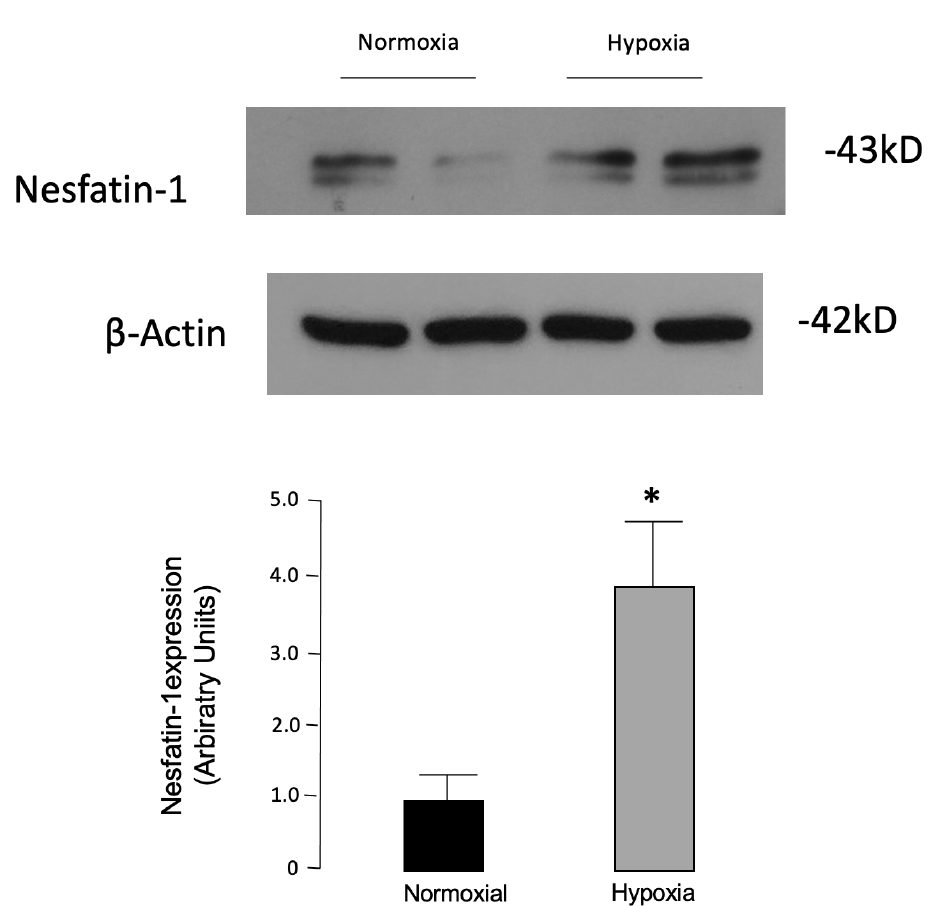
Figure 1. Effects of hypoxia on nesfatin-1 protein expression in murine 3T3-L1 adipocytes. Fully differentiated 3T3-L1 adipocytes were incubated under hypoxic conditions (2% O 2 ) for 24 h maintained in normoxia (21% O 2 ). Western blot analysis was performed with 3L3-L1 protein extracts using an anti-nesfatin antibody. Beta-actin antibody served as the protein loading control. Representative WBs of three separate experiments and mean densitometric analyses of WBs performed in 3T3-L1 cells under different oxygen tension are shown. * p < 0.003 vs. normoxia (Student’s t -test).